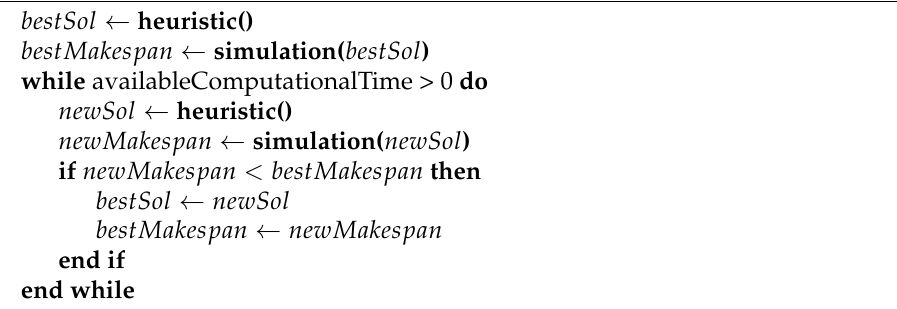
Algorithm 1 The proposed solution approach based on the